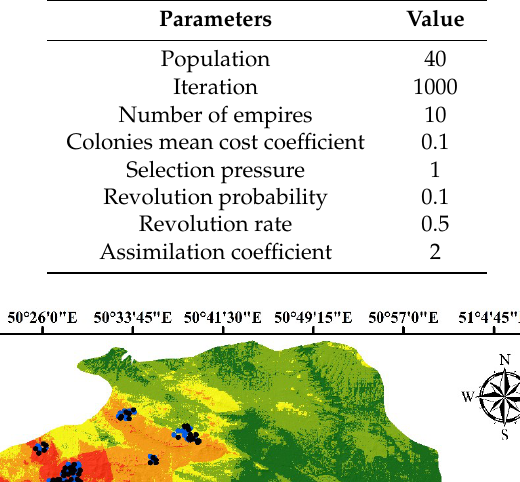
Figure 13. Result of the RBF-ICA model: ( a ) Altitude ( b ) Aspect ( c ) Slope ( d ) Distance to road ( e ) Distance to settlement ( f ) Rainfall ( g ) Temperature ( h ) Wind e ff ect. Table 6. Parameters used in the ICA algorithm.